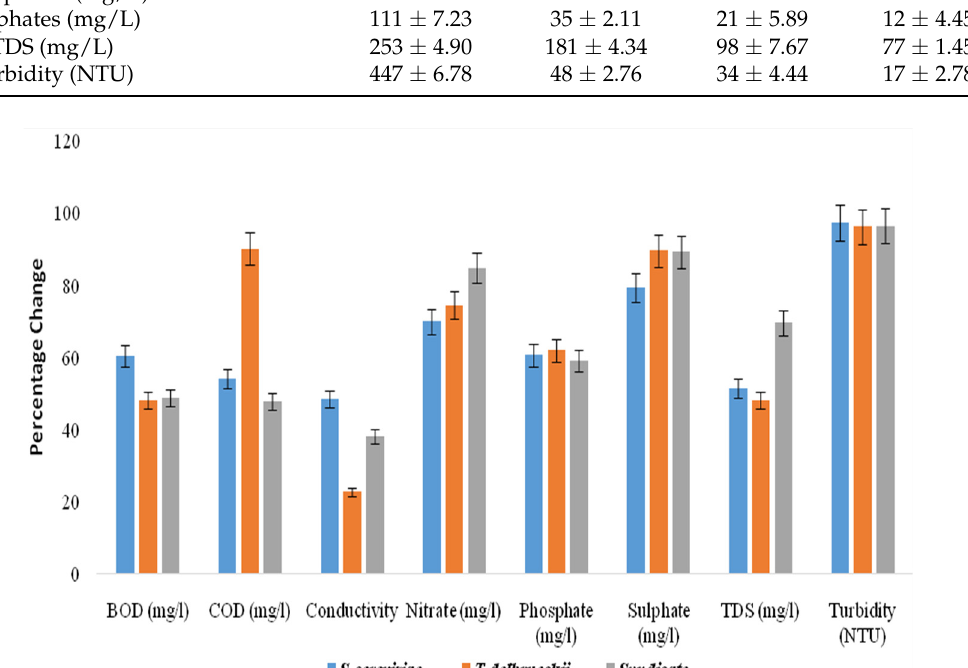
Figure 1. Percentage change in physicochemical parameters after treatment of 50% tannery effluent with individual yeast species and syndicate.